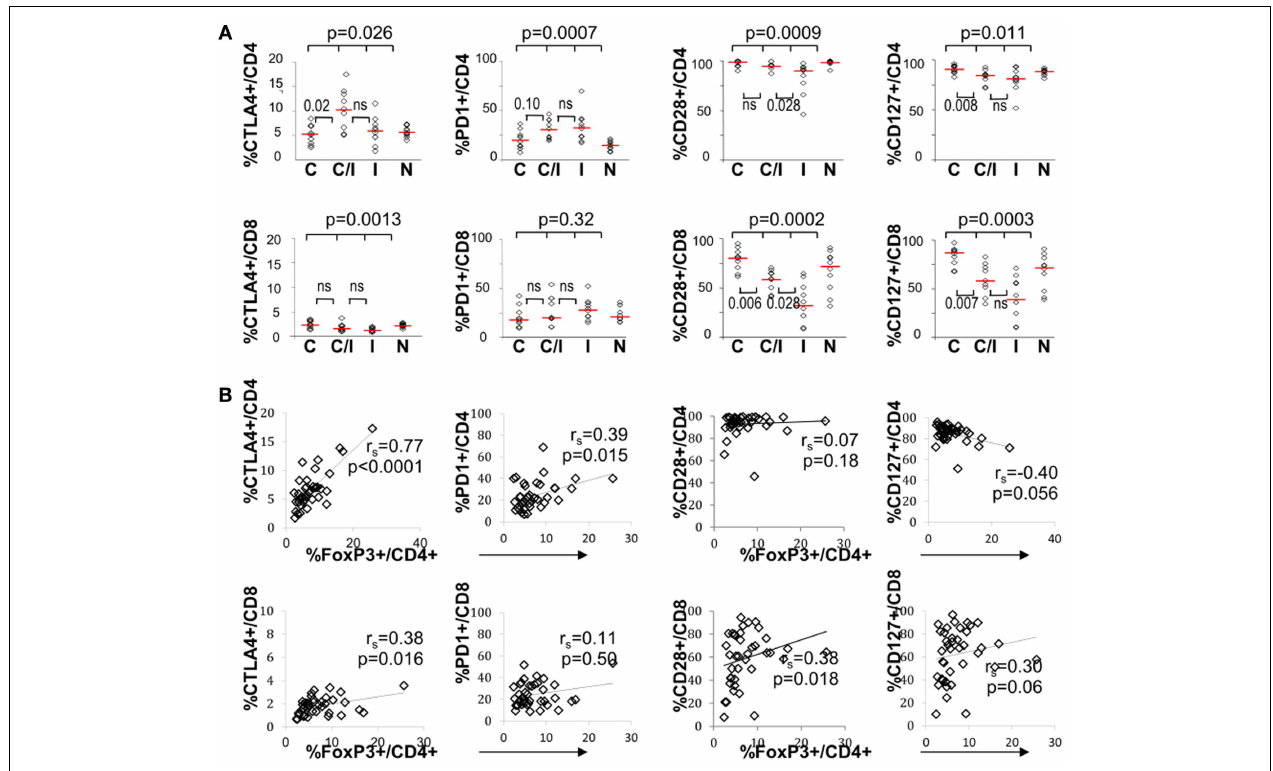
of HCV/HIV coinfection group with HCV or HIV monoinfection group was made using non-parametric Mann–Whitney U and corrected for multiple comparisons. P -values above 0.05 before correction are shown as “ns” or “not significant.” (B) Frequency of CD4 and CD8T cells expressing CTLA-4, PD-1, CD28, or CD127 are correlated with FoxP3 + Treg frequency in the CD4 T cell compartment, with non-parametric Spearman rank-order correlation and P